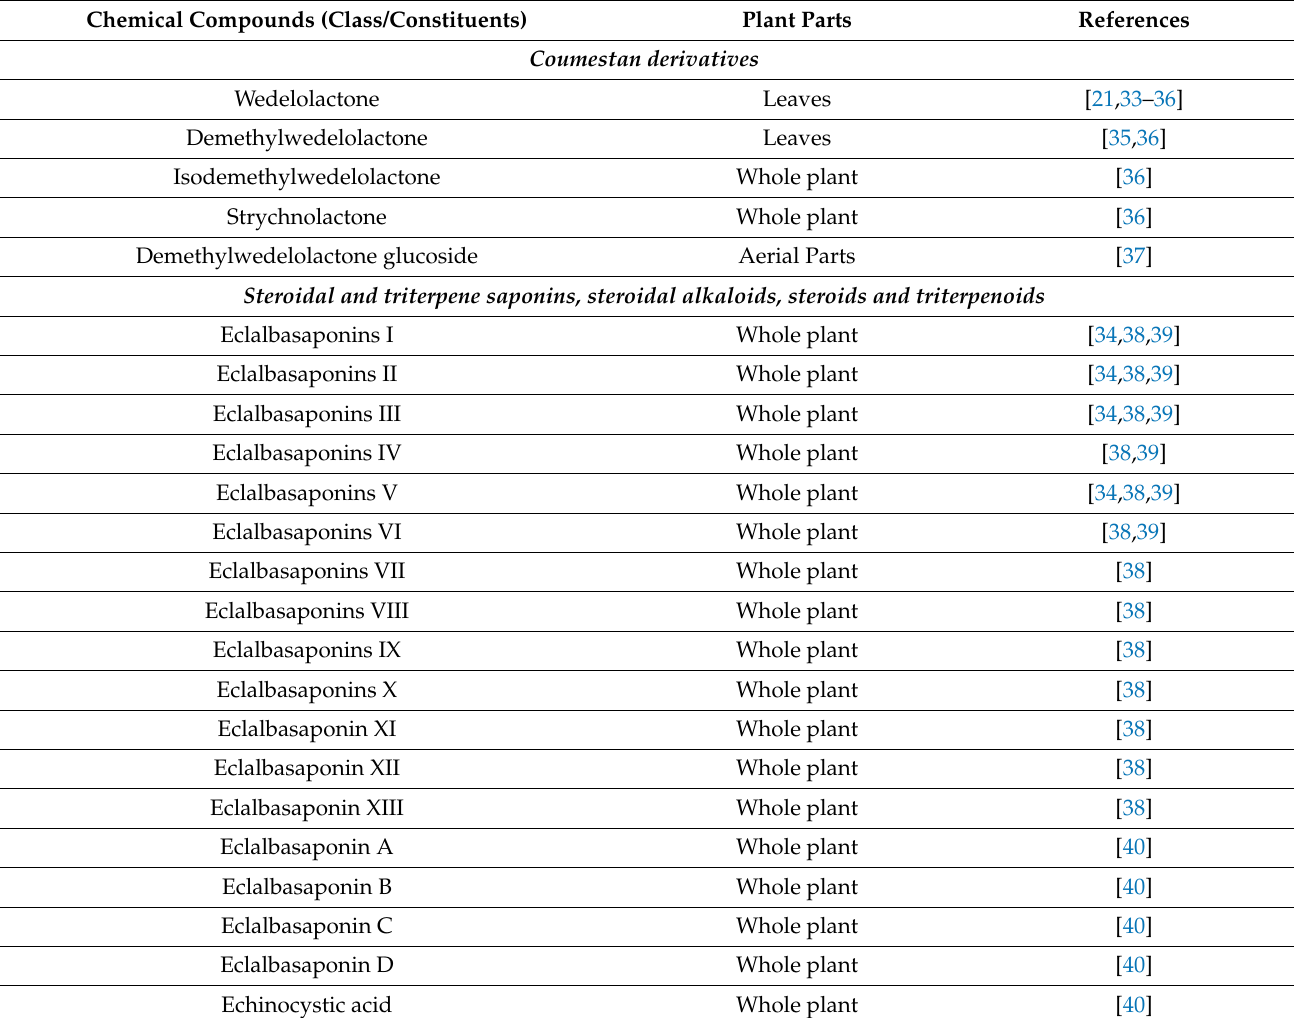
Table 1. Coumestan, steroid and triterpene derivatives and related compounds from various parts of E. prostrata . Chemical Compounds